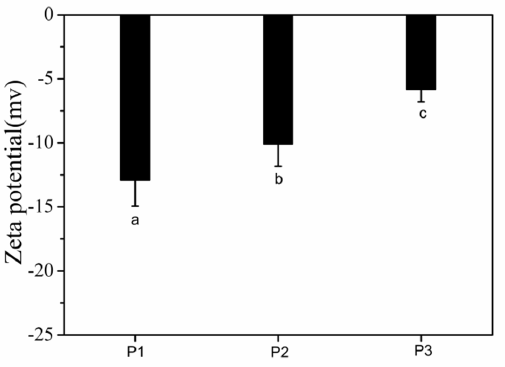
Figure 2. Zeta potential of three molecular weight peptide fractions; bars in each chart with different letters represent significantly different mean values with P < 0.05.